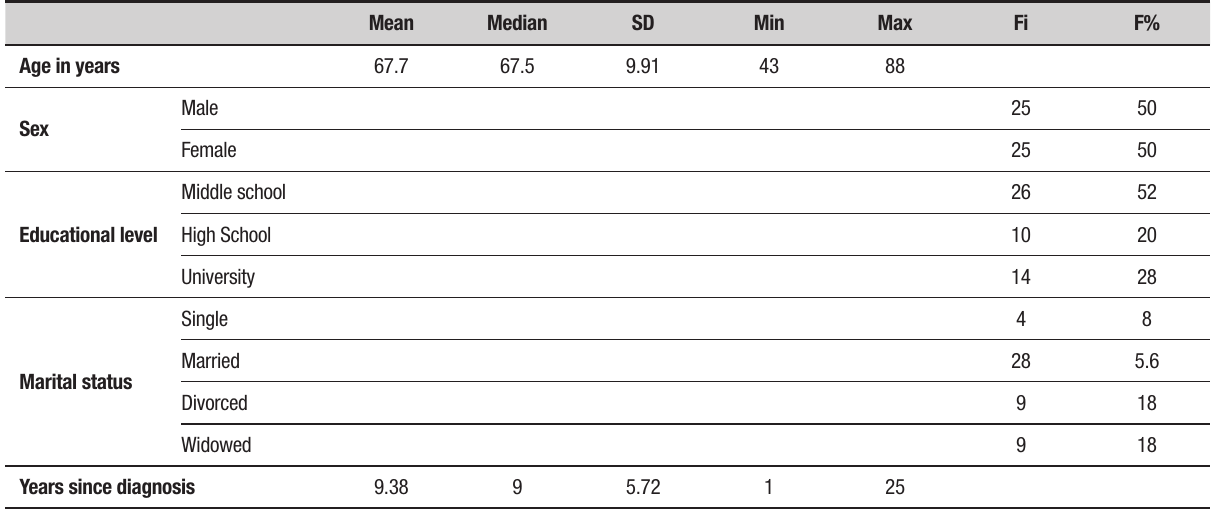
Table 1. Demographic data for the sample (n=50).